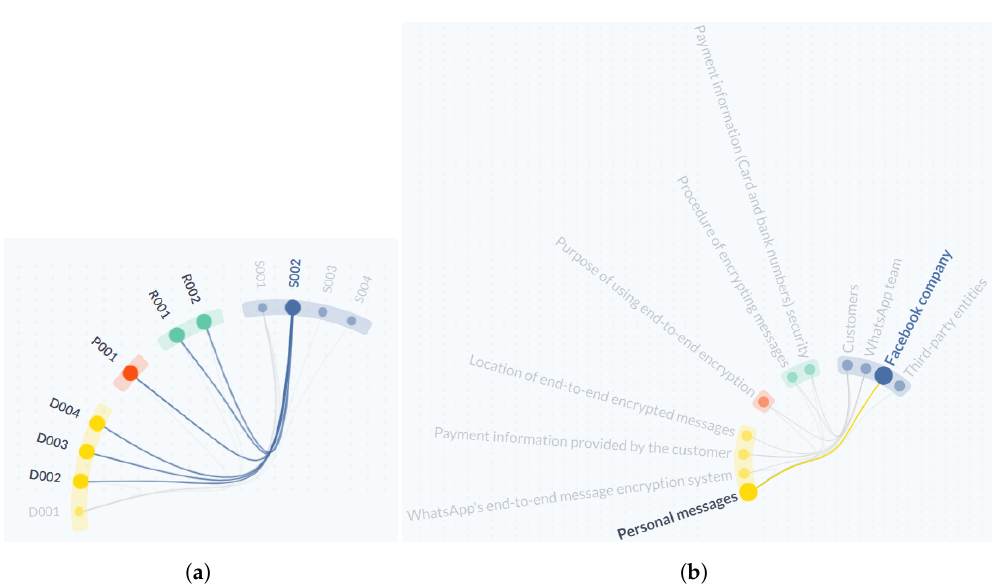
Figure 12. T RANSP V IS : ( a ) Selecting “WhatsApp team” keyword and ( b ) mouse-over action of “Personal messages” in WhatsApp